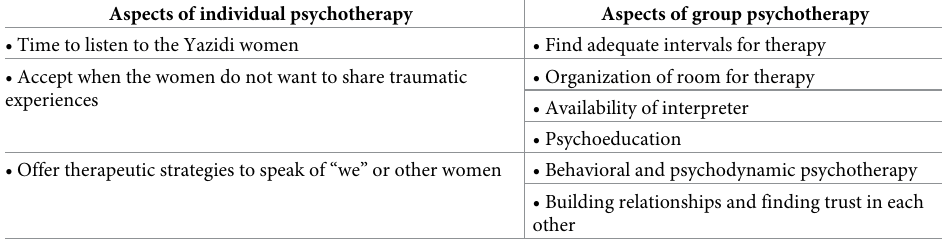
Table 5. Helpful strategies for individual and group psychotherapy from the care providers’